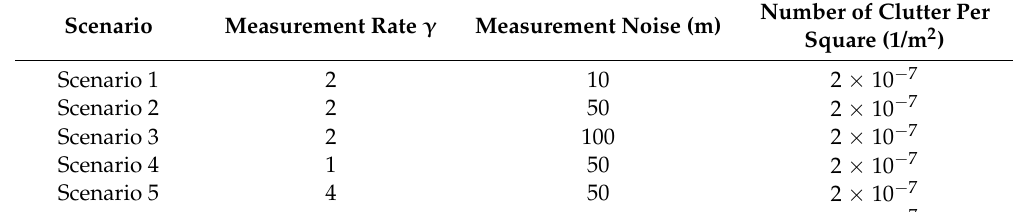
Table 1. The parameters of the scenarios.